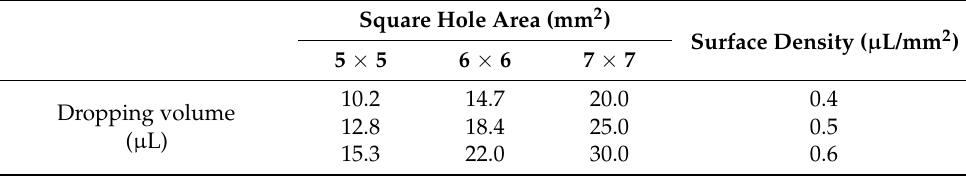
Table 1. Different combination parameters of the square hole area and dropping volume.